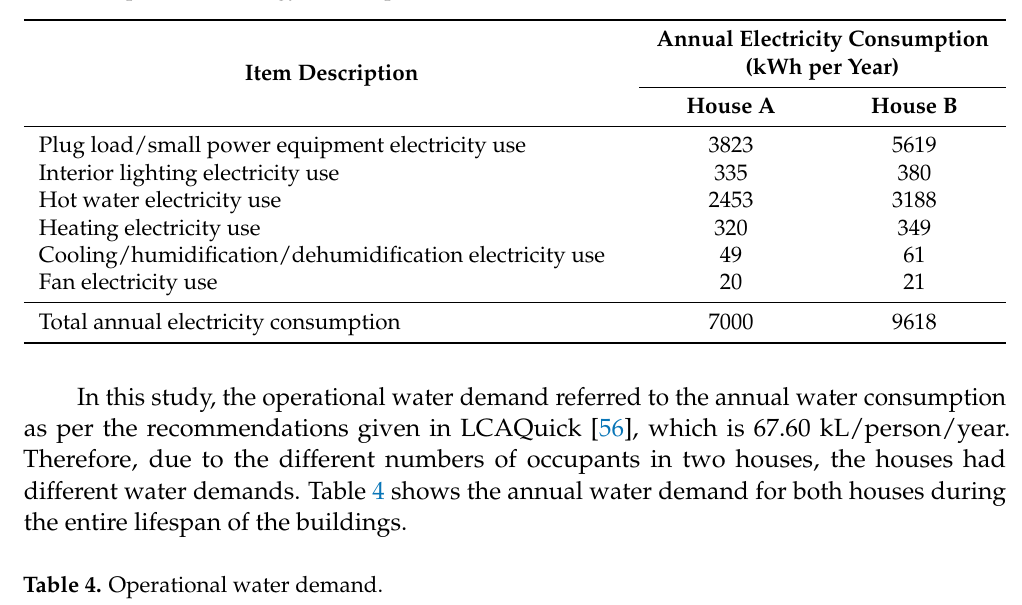
Table 3. Operational energy consumption.